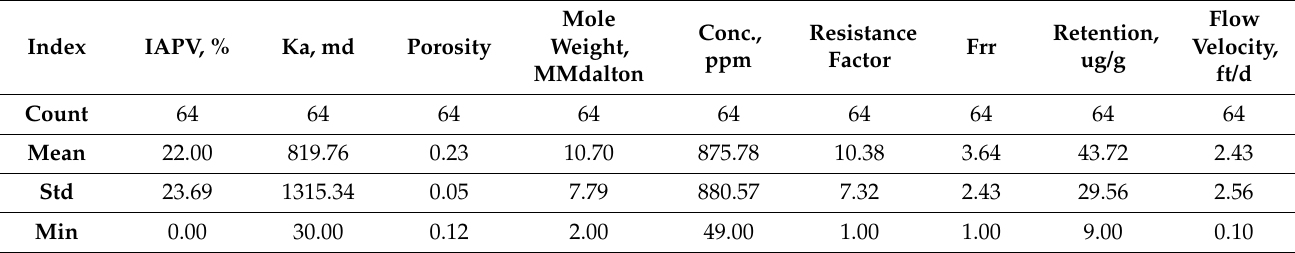
Table 1. The descriptive information of the collected